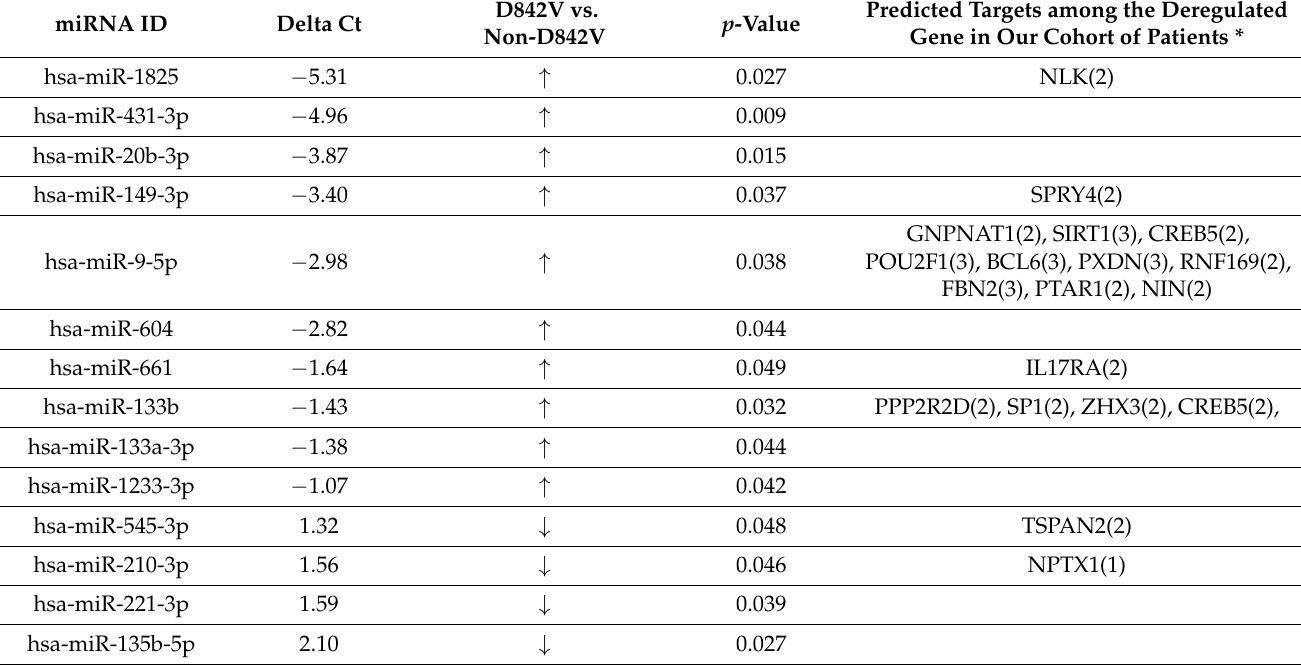
Predicted Targets among the